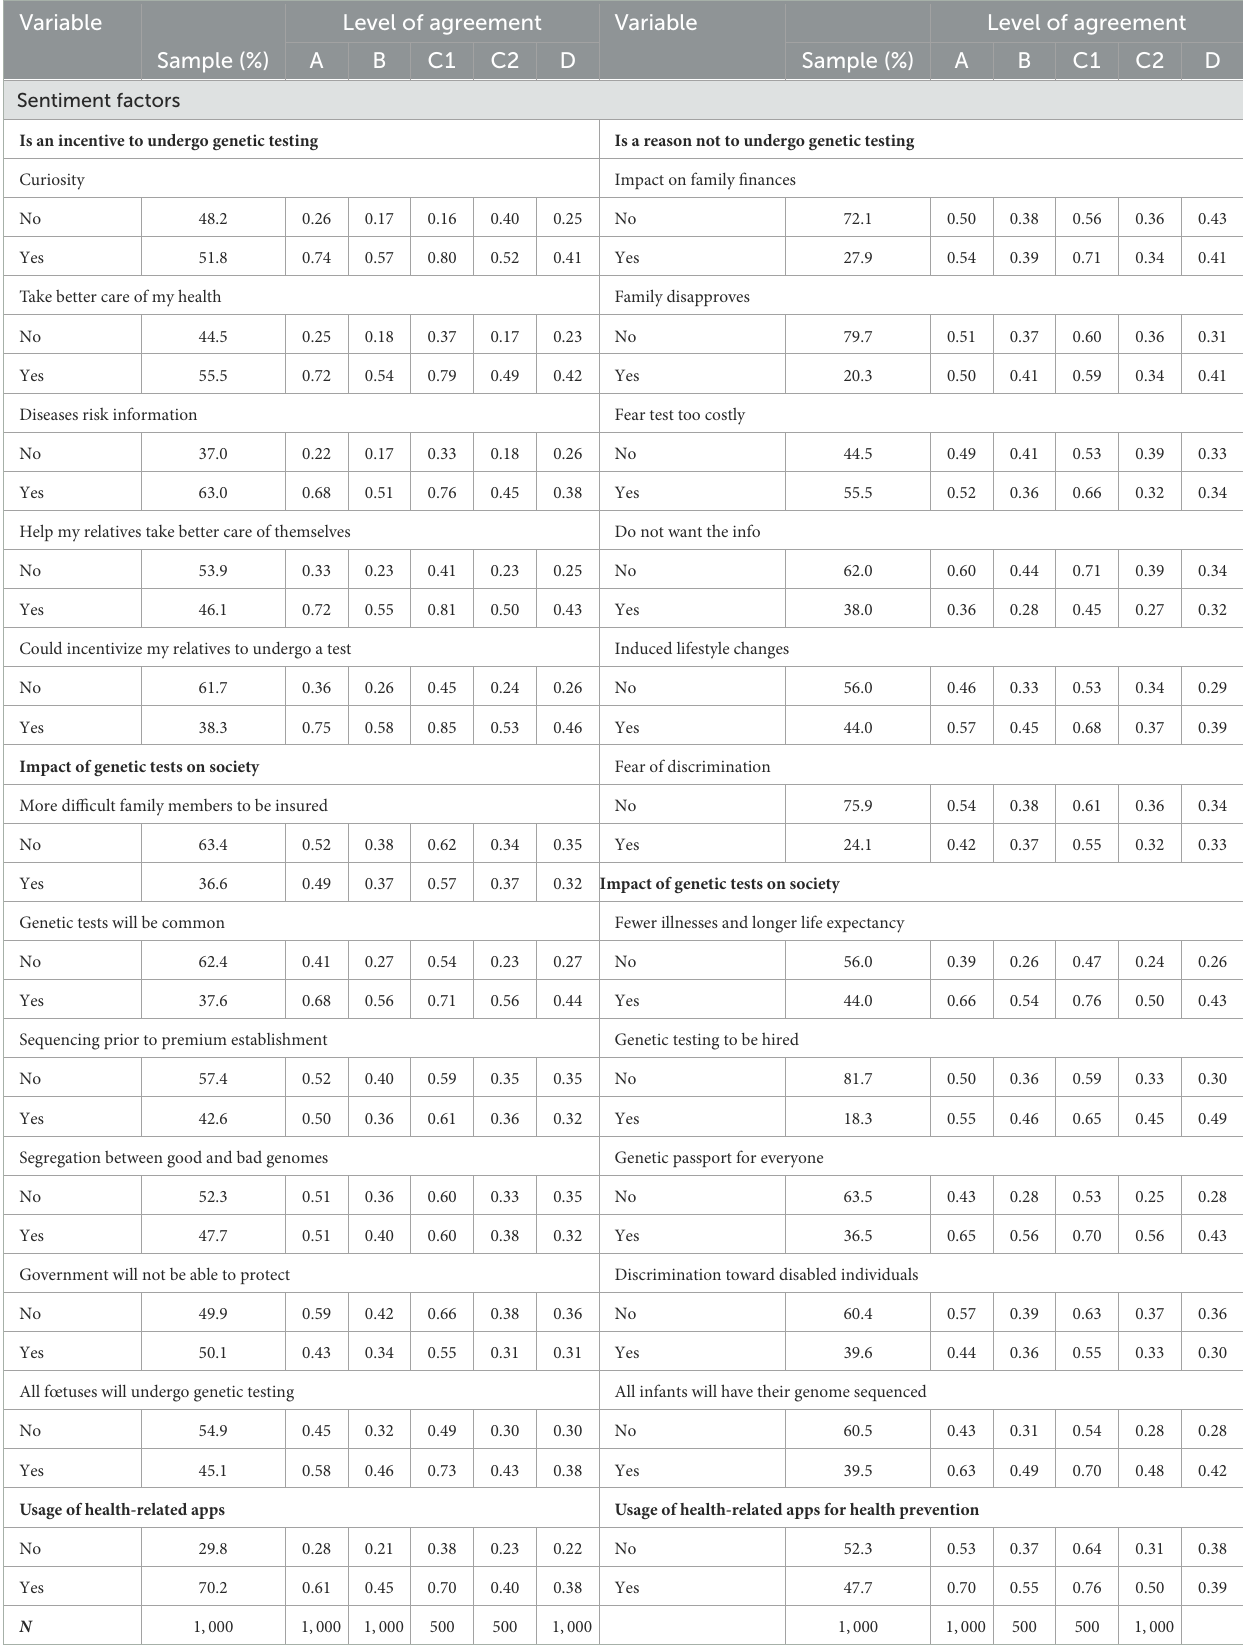
TABLE 4 Descriptive statistics: Willingness to undergo a genetic test and share the data per variable. Variable Level of agreement Variable Level of